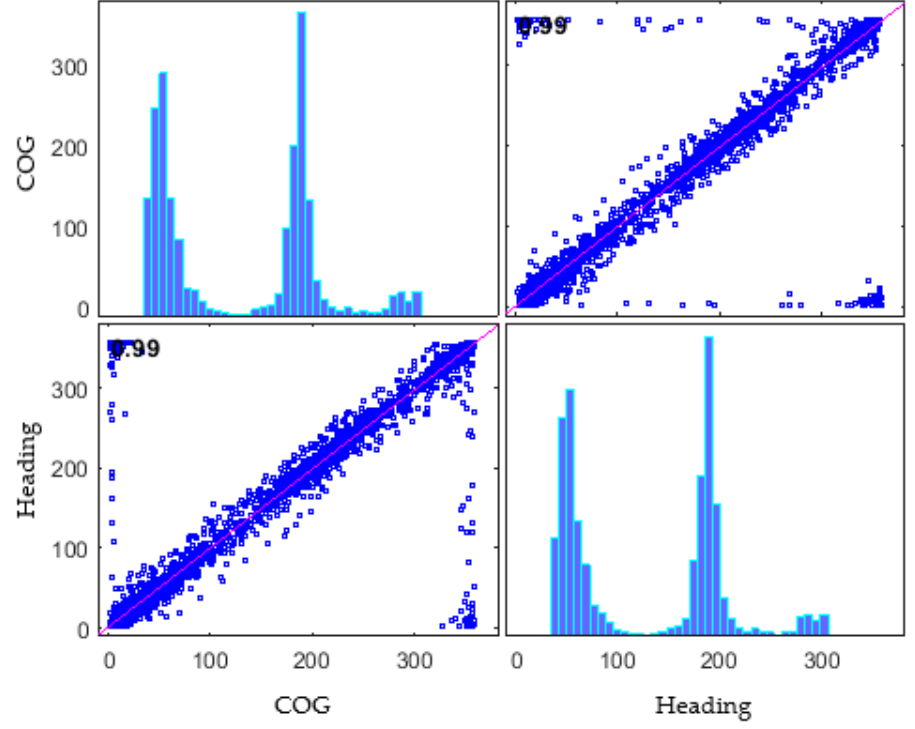
Figure 5. Correlation coefficient plot between COG and heading.